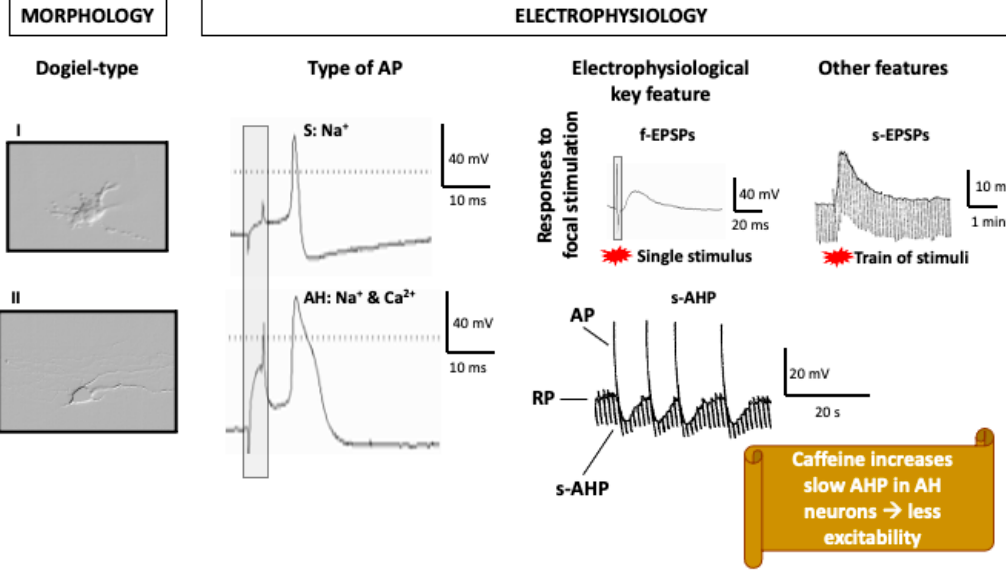
Figure 3. Morphological and electrophysiologic features of myenteric neurons and effect of caffeine on AH/II neurons. By use of intracellular recording methods illustrated in Figure 2, two main classes of myenteric neurons can be distinguished. According to morphology (left), neurons are classified as Dogiel type I (top) or Dogiel type II (bottom). These neurons broadly correspond to electrophysiological types S and AH, respectively. S neurons display short sodium-dependent APs, whereas APs of AH neurons are wider and depend on the entry of both Na + and Ca 2+ , displaying a “hump” during the falling phase of the AP, due to Ca 2+ entry. S neurons respond to single focal electrical stimuli with fast excitatory postsynaptic potentials (f-EPSPs), which are not seen in AH neurons, although both classes may respond to trains of focal stimulation with slow excitatory postsynaptic potentials (s-EPSPs). Finally, AH neurons display a s-AHP, due to K + efflux dependent on the increase in intracellular free Ca 2+ ([Ca 2+ ]i) released from ryanodine-dependent stores. This s-AHP is increased and prolonged by caffeine, making these neurons, which are intrinsic peripheral nerve afferents, less excitable. Abbreviations: AP, action potential; f-EPSP, fast excitatory postsynaptic potential; RP, resting potential; s-AHP, slow after hyperpolarization; s-EPSP, slow excitatory postsynaptic potentials. Light grey blocks with dotted border, artifact of the stimulus; red blast symbol, focal stimulus.